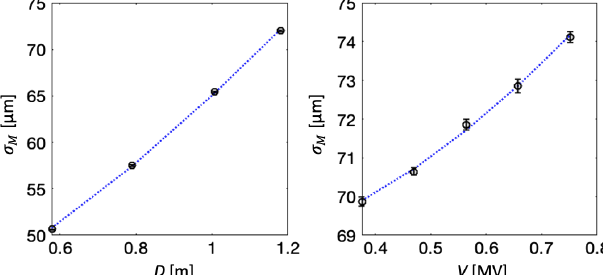
FIG. 13. The black circles with error bars at the left plot show the measured slice width σ M for different dispersion values D . The black circles with error bars at the right plot show the measured slice width σ M for different values of the TDS voltage V . The blue dotted lines are obtained by the numerical fit to Eq. (8) and Eq.